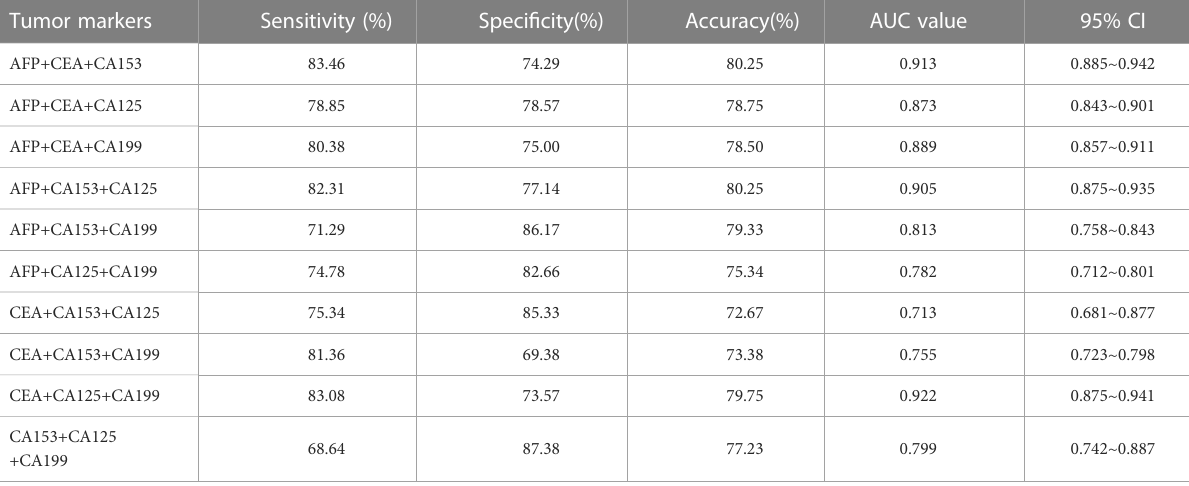
TABLE 5 Analysis of Detection Results of Three Parallel Methods for Tumor Markers.